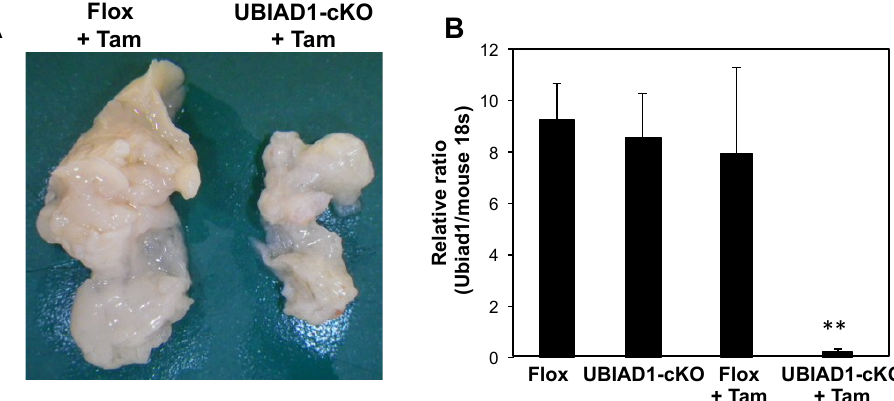
Figure 2. Morphological changes and UBIAD1 messenger RNA (mRNA) expression in the pancreas of tamoxifen-treated UBIAD1-cKO female mice. ( A ) Morphological changes in the pancreas of tamoxifen-treated Flox and UBIAD1-cKO female mice; ( B ) UBIAD1 mRNA expression in the pancreas of tamoxifen-treated or non-treated Flox and UBIAD1-cKO female mice. Data are shown as means ± standard errors of the mean (SEM); ** p < 0.01 compared with the corresponding value in other group of mice.